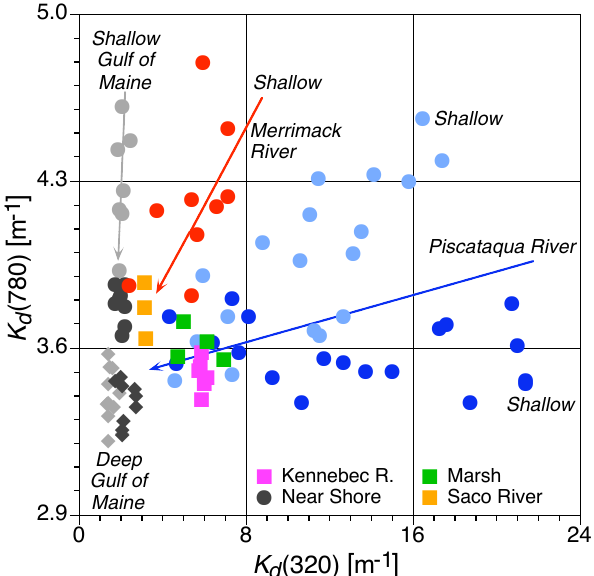
Fig. 6. A plot of K d ( 320 ) versus K d ( 780 ) for the Gulf of Maine sampling done in the vicinity of Portsmouth, New Hampshire. The sampling included the following water masses: an offshore- to-onshore Gulf of Maine transect through the Wilkinson Basin (light gray diamonds), which ended in shallow waters (light gray circles); individual Gulf of Maine deep stations, which are sepa- rated into deep (dark gray diamonds) and shallow or near-shore waters (dark gray circles); the Merrimack River (red circles); the Piscataqua River (blue circles) with the major branch of the Pis- cataqua River (dark blue circles) incorporating Great Bay and Little Bay shown separately (light blue circles); the Saco River (orange squares); the Kennebec River (pink squares); and a coastal marsh (green squares). The overlaid arrows are color coded to the corre- sponding data sets and show a progression in water properties from shallow head waters (top and right of plot) to deep outflow waters (bottom and left of plot).